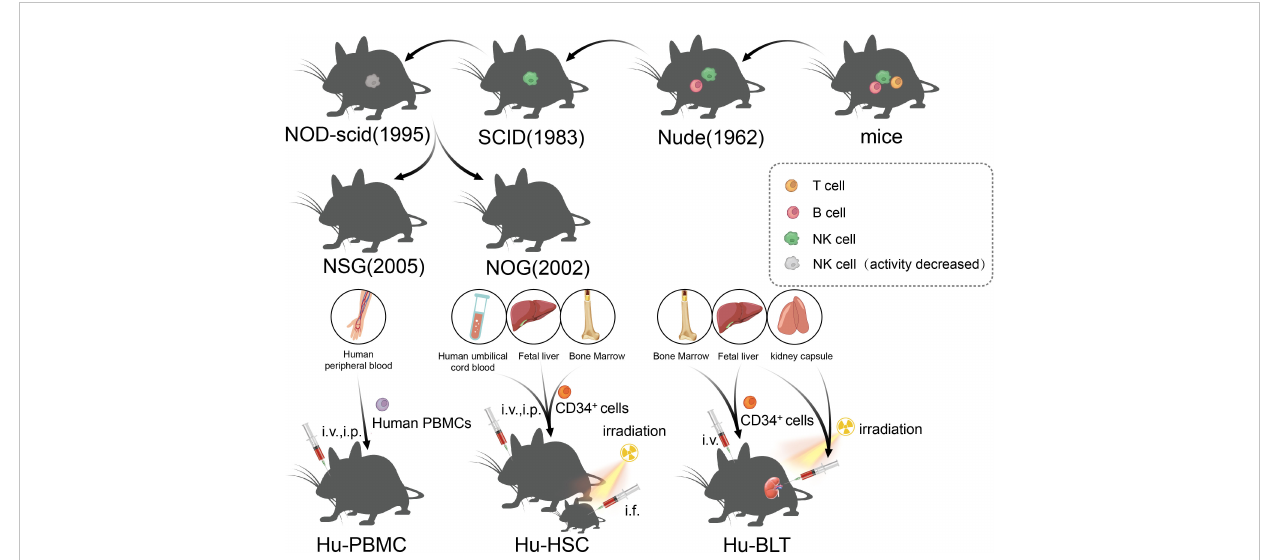
FIGURE 3 The development of immunode fi cient mice and the construction method of the humanized mice